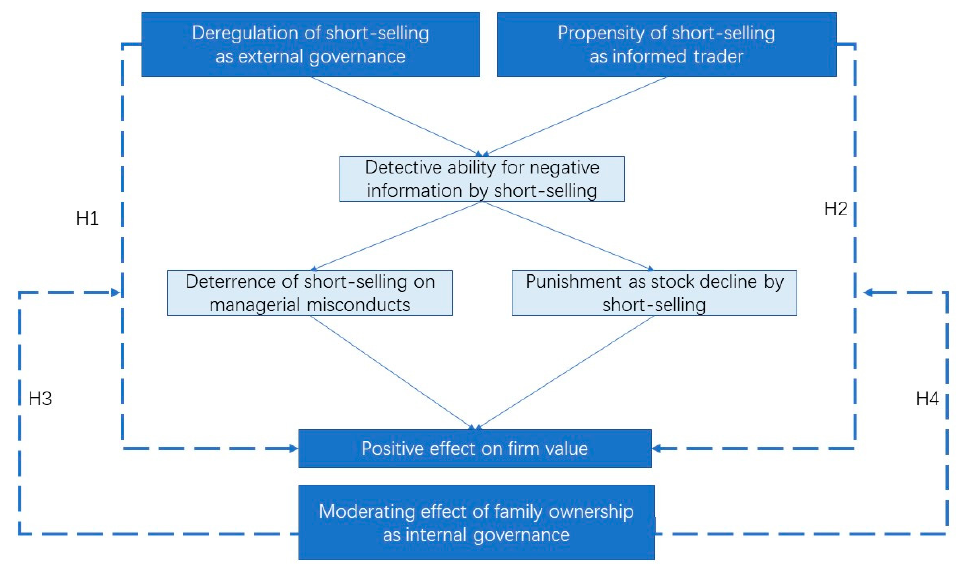
Figure 1. Hypotheses development .